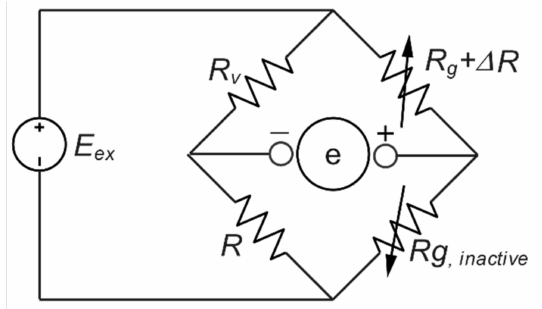
Figure 3. Half-Wheatstone bridge configuration.